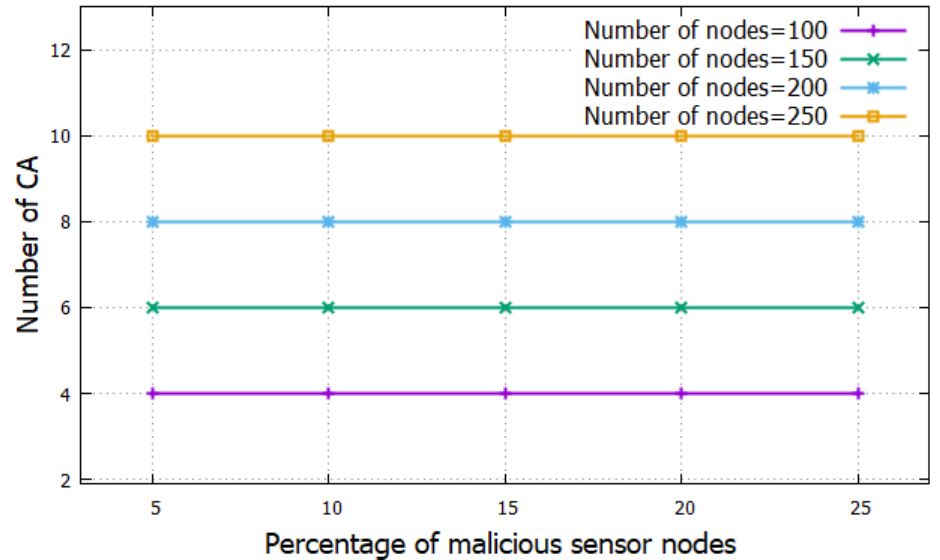
13 Figure 3. Number of CA as a function of the transmission range. Figure 4 shows the number of CAs as a function of the percentage of malicious sensor nodes in the network. It is obvious in Figure 4 that the percentage of malicious nodes in the network does not affect the number of CA. The number of CA is constant on increasing